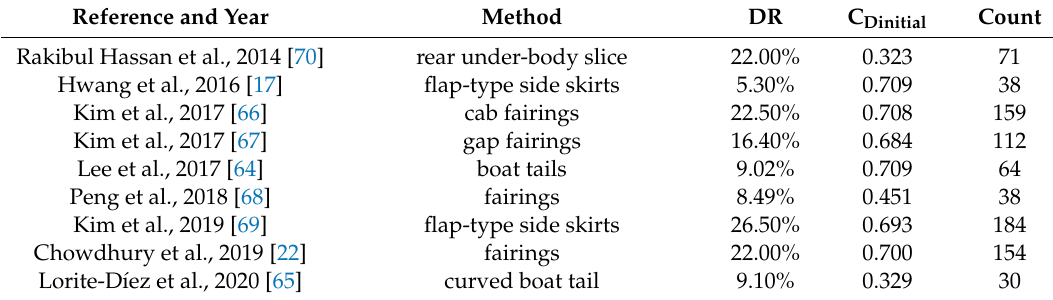
Table 2. Maximum DR by shape